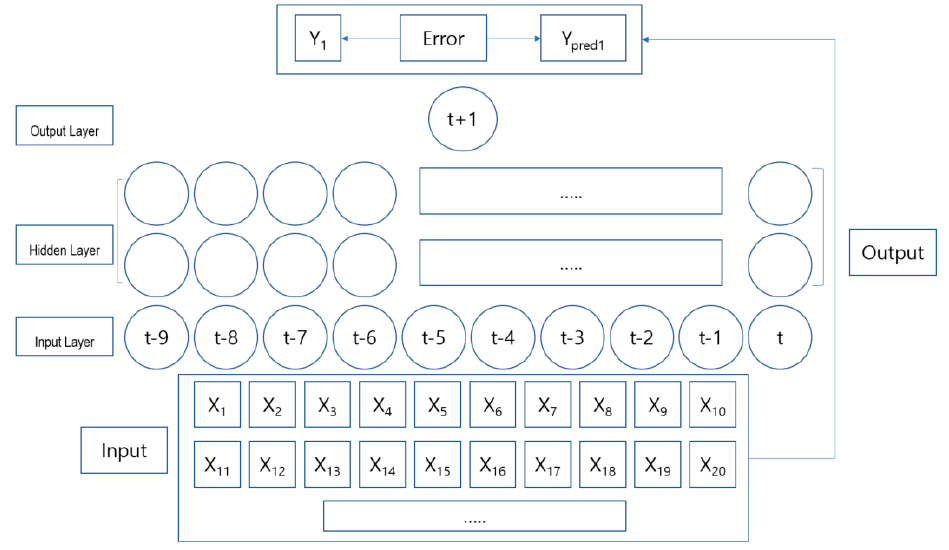
Figure 7. Structure of designed RNN.